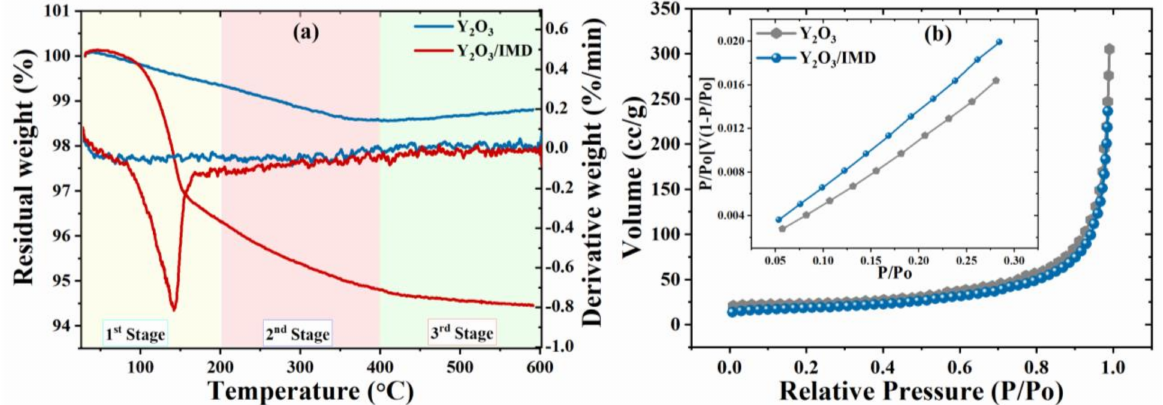
Figure 4. ( a ) TGA and DTA, ( b ) B.E.T analysis of Y 2 O 3 and Y 2 O 3 /imidazole. The changes in the cumulative pore volume and specific surface area (SSA) for Y 2 O 3 and Y 2 O 3 /imidazole are observed by Brunauer–Emmett–Teller (B.E.T.) analysis—Figure 4b. The SSA value for Y 2 O 3 is 73.729 m 2 g − 1 before loading, but it is reduced to 62.671 m 2 g − 1 after loading with imidazole. Similar to SSA, the cumulative pore volume reduced from 0.4744 ccg − 1 to 0.3675 ccg − 1 after loading. The reduction in SSA and cumulative pore volume confirms the loading of imidazole into Y 2 O 3